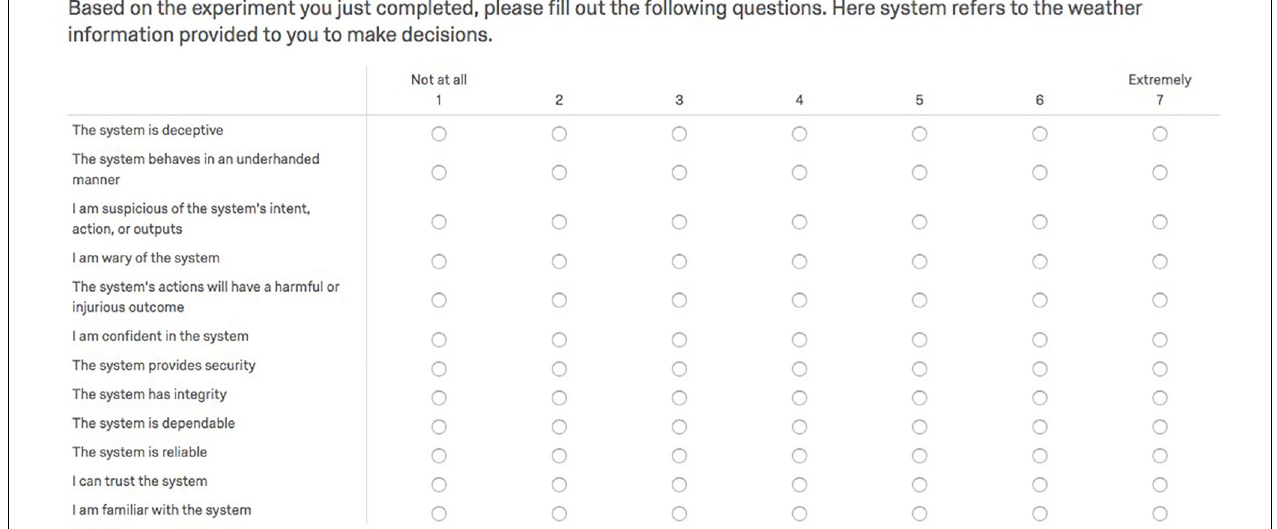
FIGURE 7 | Trust in automation scale by Jian et al. (2000).